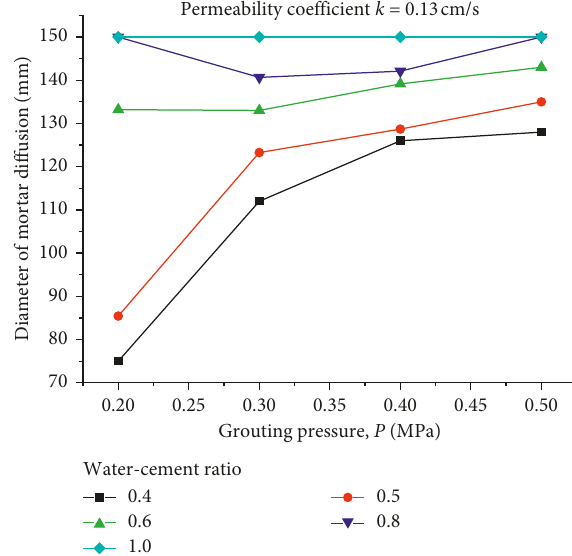
Figure 11: Characteristics of slurry diffusion ( k